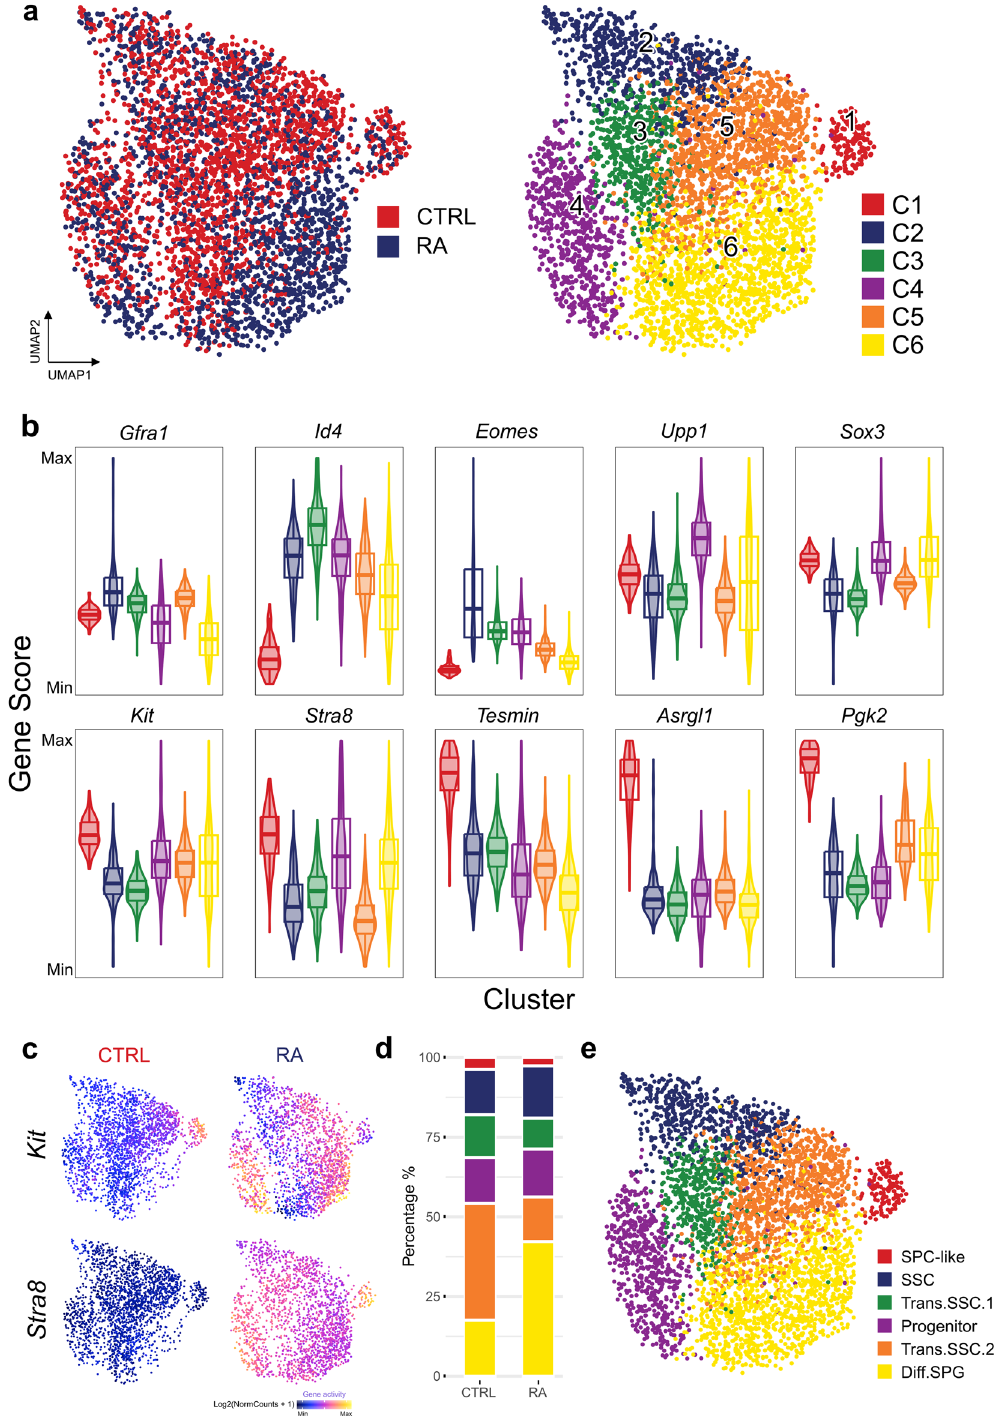
Figure 3. Defining the differentiation status in germline stem cells (GSCs) by gene activity. ( a ) UMAP representation of all cells. Cells are colored by samples (left) and by cell clusters (right). ( b ) Violin plots showing gene activity scores of the selected genes. ( c ) Gene activity scores of Kit (top) and Stra8 (bottom) in CTRL and RA samples shown in UMAP. ( d ) Bar chart showing the distribution of cells in each cluster. ( e ) Annotation of cell states visualized using UMAP from